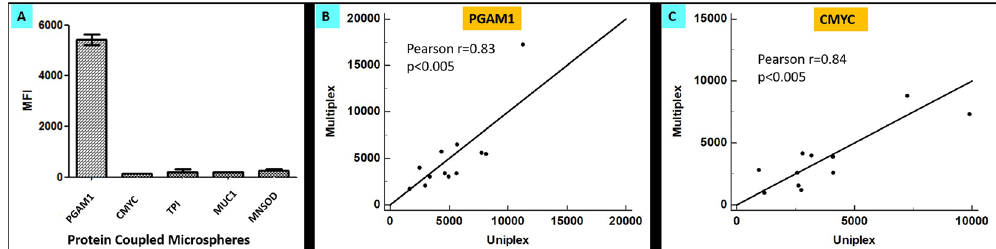
Figure 5. No cross-reactivity between individual protein-coupled microspheres in the multiplex system. ( A ) Multiplex system containing five microspheres coupled with TPI, MNSOD, PGAM1, MUC1 and CMYC was incubated with PGAM1 antibody, and only the PGAM1 microspheres reacted with anti-PGAM1 antibody, while other microspheres detected the background MFI values. ( B ) The signal correlation of the PGAM1 coupled microspheres in the singleplex and multiplex system. ( C ) Same as ( B ) but using CMYC coupled microspheres. The correlation between uniplex and multiplex systems was calculated by comparing the autoantibody signals generated from randomly selected serum samples (n = 12) by both the systems. The correlation coefficient (Pearson, r) was 0.83 for PGAM1 and 0.84 for CMYC (p < 0.005), indicating a significant correlation between the uniplex and multiplex